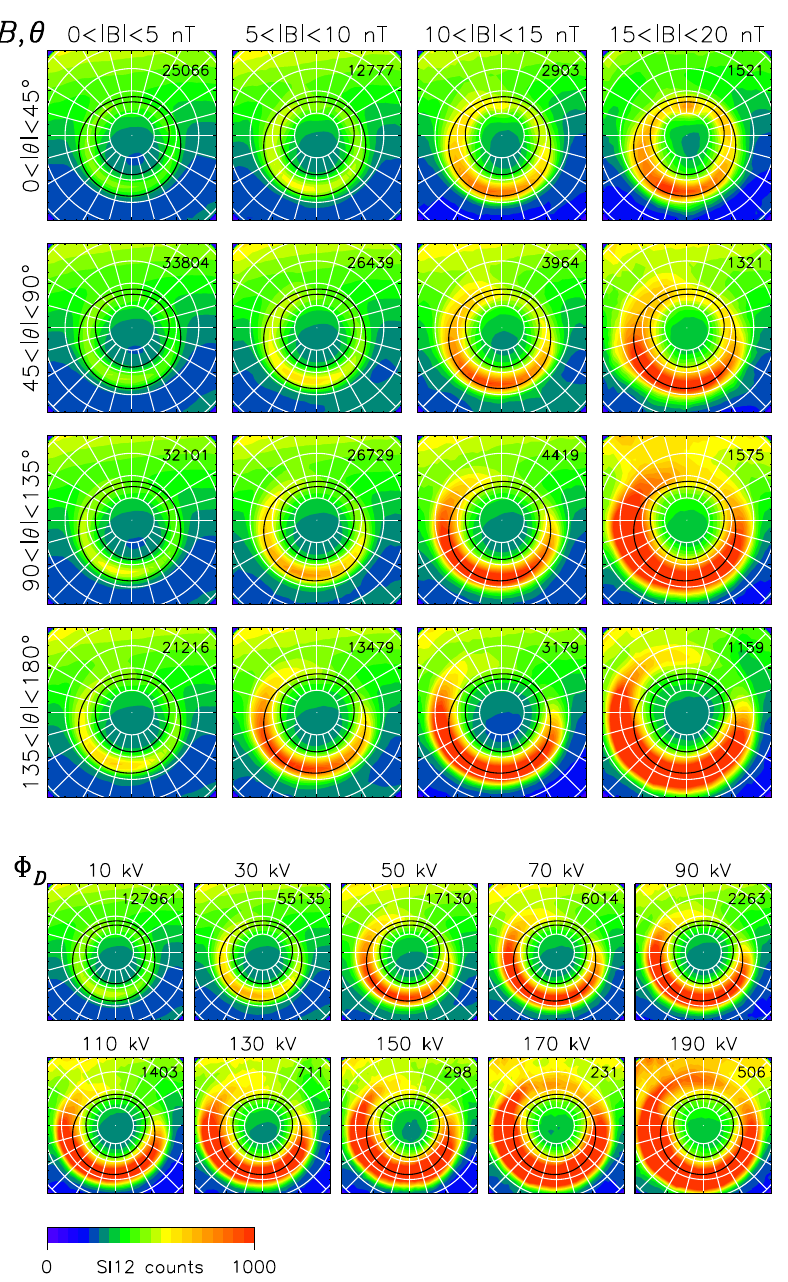
Fig. 2. Averaged SI12 observations parameterized by IMF magnitude and clock angle (top panels) and estimated dayside reconnection rate (bottom